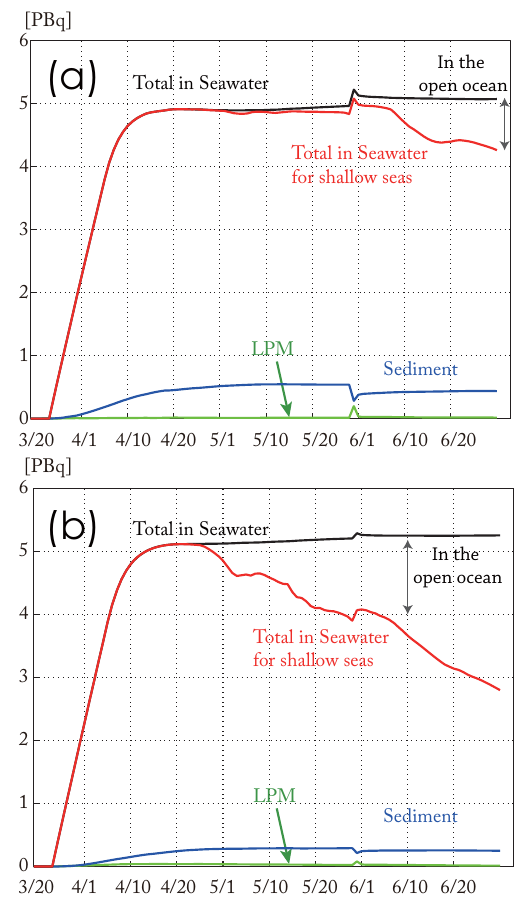
Fig. 8. (a) Time series of radionuclides in CTRL. (b) Time series of radionuclides in SMIX. Green and blue lines show the radionuclides in LPM phase and bottom sediment phase, respectively. Black solid line is the sum of radionuclides in dissolved and LPM phases in- cluding those that exited from the model domain. Red line is the sum of radionuclides in dissolved and LPM phases that are located in shallow seas ( < 200m). The difference between the black and red lines is the number of radionuclides in the open ocean ( >